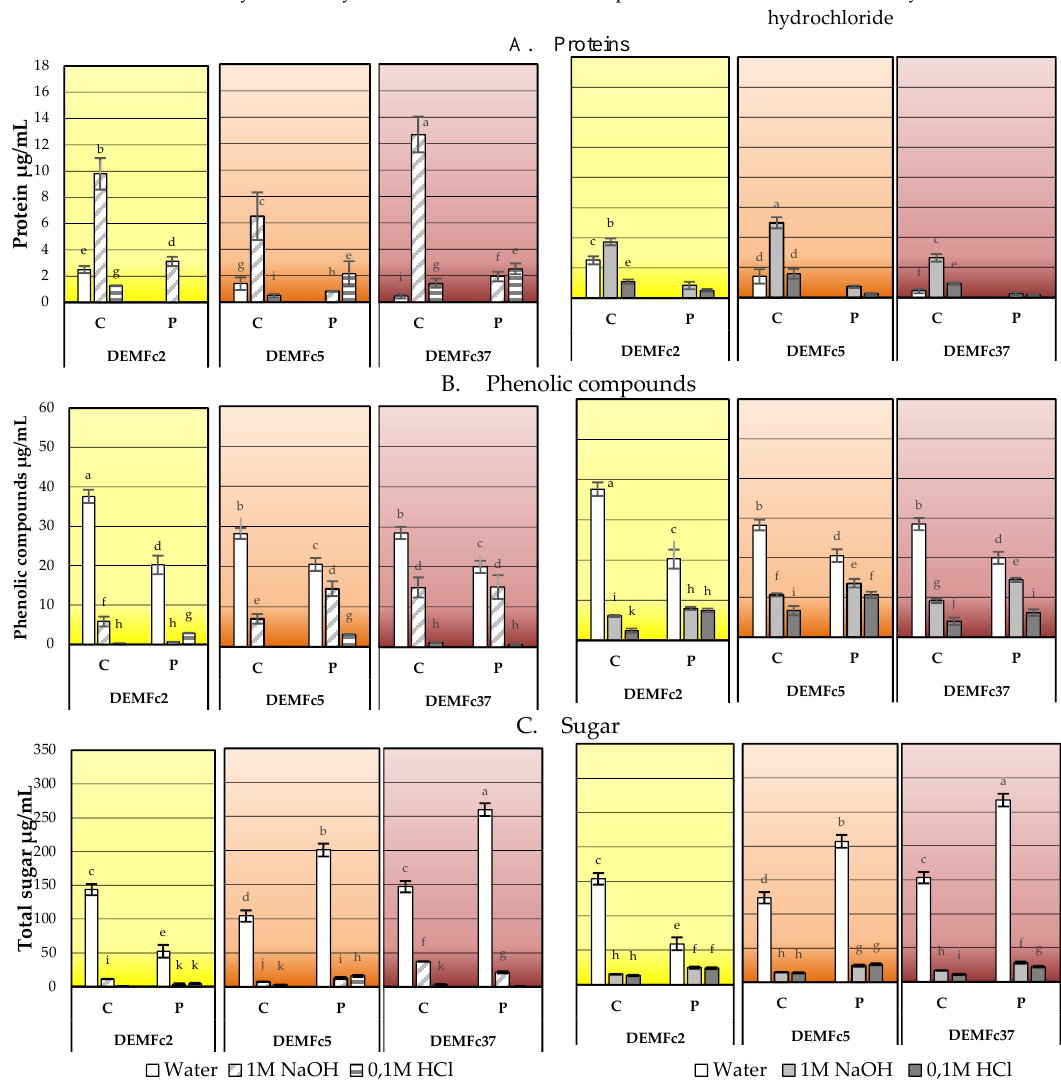
Figure 10. Concentration of protein ( A ), phenolic compounds ( B ) and total sugar ( C ) in ( I ). Solutions (water, sodium hydroxide, hydrochloride) obtained by dissolving EPS directly in each of the three solvents and ( II ). fractions (aqueous-water, alkalic-sodium hydroxide, acidic-hydrochloride), obtained in step fractionation of crude (C) and proteolysed (P) EPS obtained from cultures of three F. culmorum strains: DEMFc2, DEMFc5, and DEMFc37. ANOVA with post hoc Tukey’s HSD test, p < 0.05. Mean values labeled with the same letter within the same series are not significantly different ( p > 0.05). Standard deviations are shown as deviation bars ( n = 9).